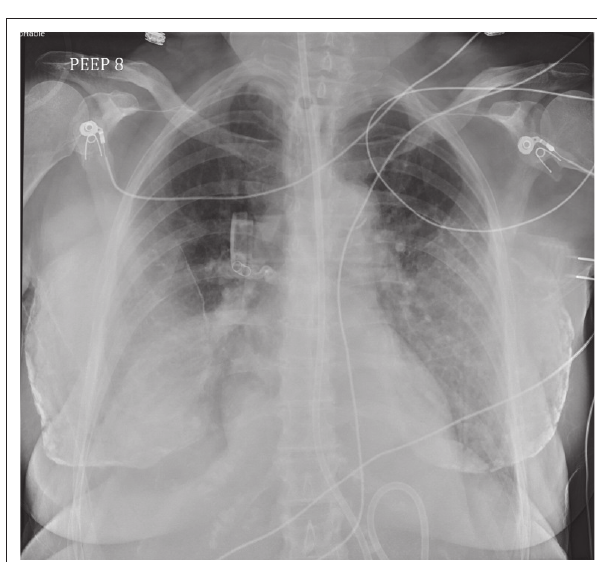
FIGURE 10: Chest radiograph showing heavily calcified breast implants obscuring the lung